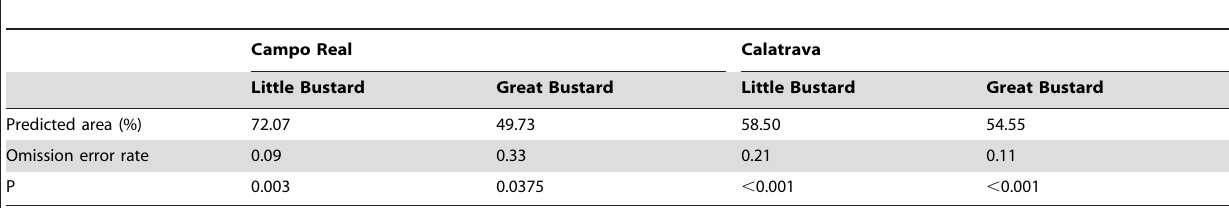
Table 1. Percentage of predicted presence area of Little and Great Bustards in Campo Real 2012 and Calatrava 2009 (corresponding with the evaluation